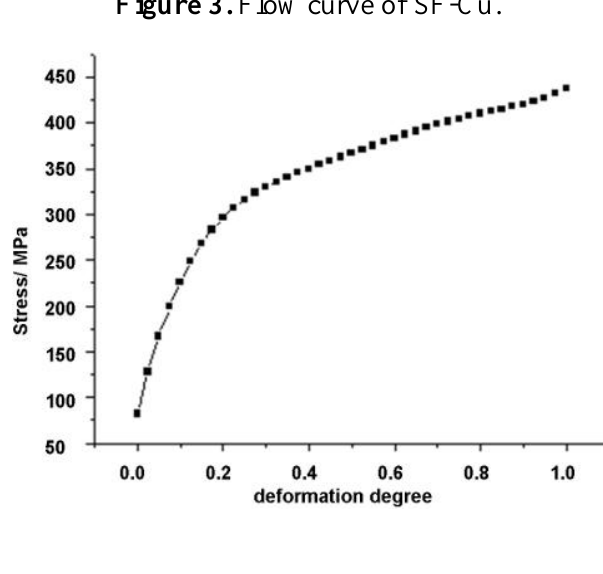
Figure 3. Flow curve of SF-Cu.